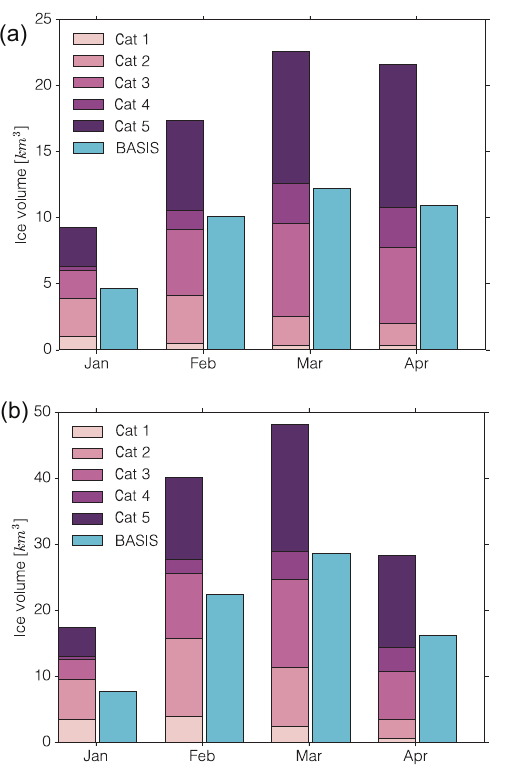
Figure 13. Climatological mean sea-ice volume for January–April, for the period 1961/1962–1978/1979, calculated for (a) the Both- nian Bay and (b) the entire Baltic Sea. Note that the NEMO-Nordic ice volumes are calculated for each ice category and the sum gives the total simulated ice volume.